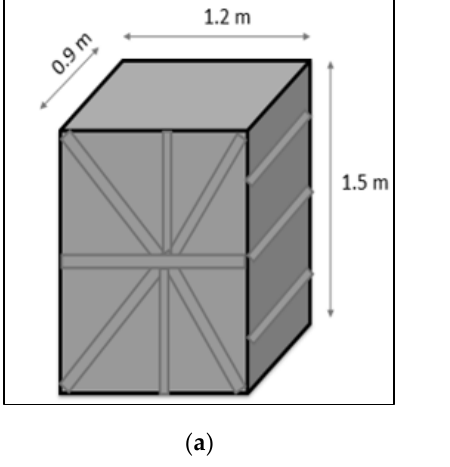
Figure 2. ( a ) Soil box; ( b ) stiffeners on each side.